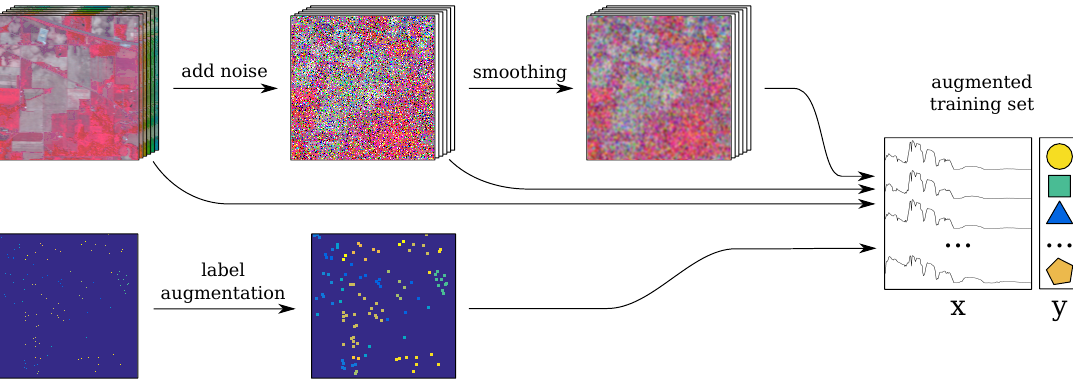
Figure 4. CNN-RSL (Regularization (R), Smoothing-based data augmentation (S) and Label-based data augmentation (L)) data processing flowchart. Data augmentation is applied to the original hyperspectral image. The labeled pixels from each of the three hyperspectral images (original, noisy and smoothed) form the training set ( x , y ) , which is used to train the CNN with the spectral locality-aware regularization term